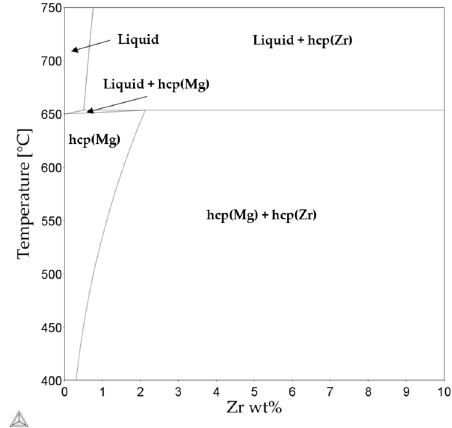
Figure 9. Calculated Mg-Zr binary phase diagram [49,50].